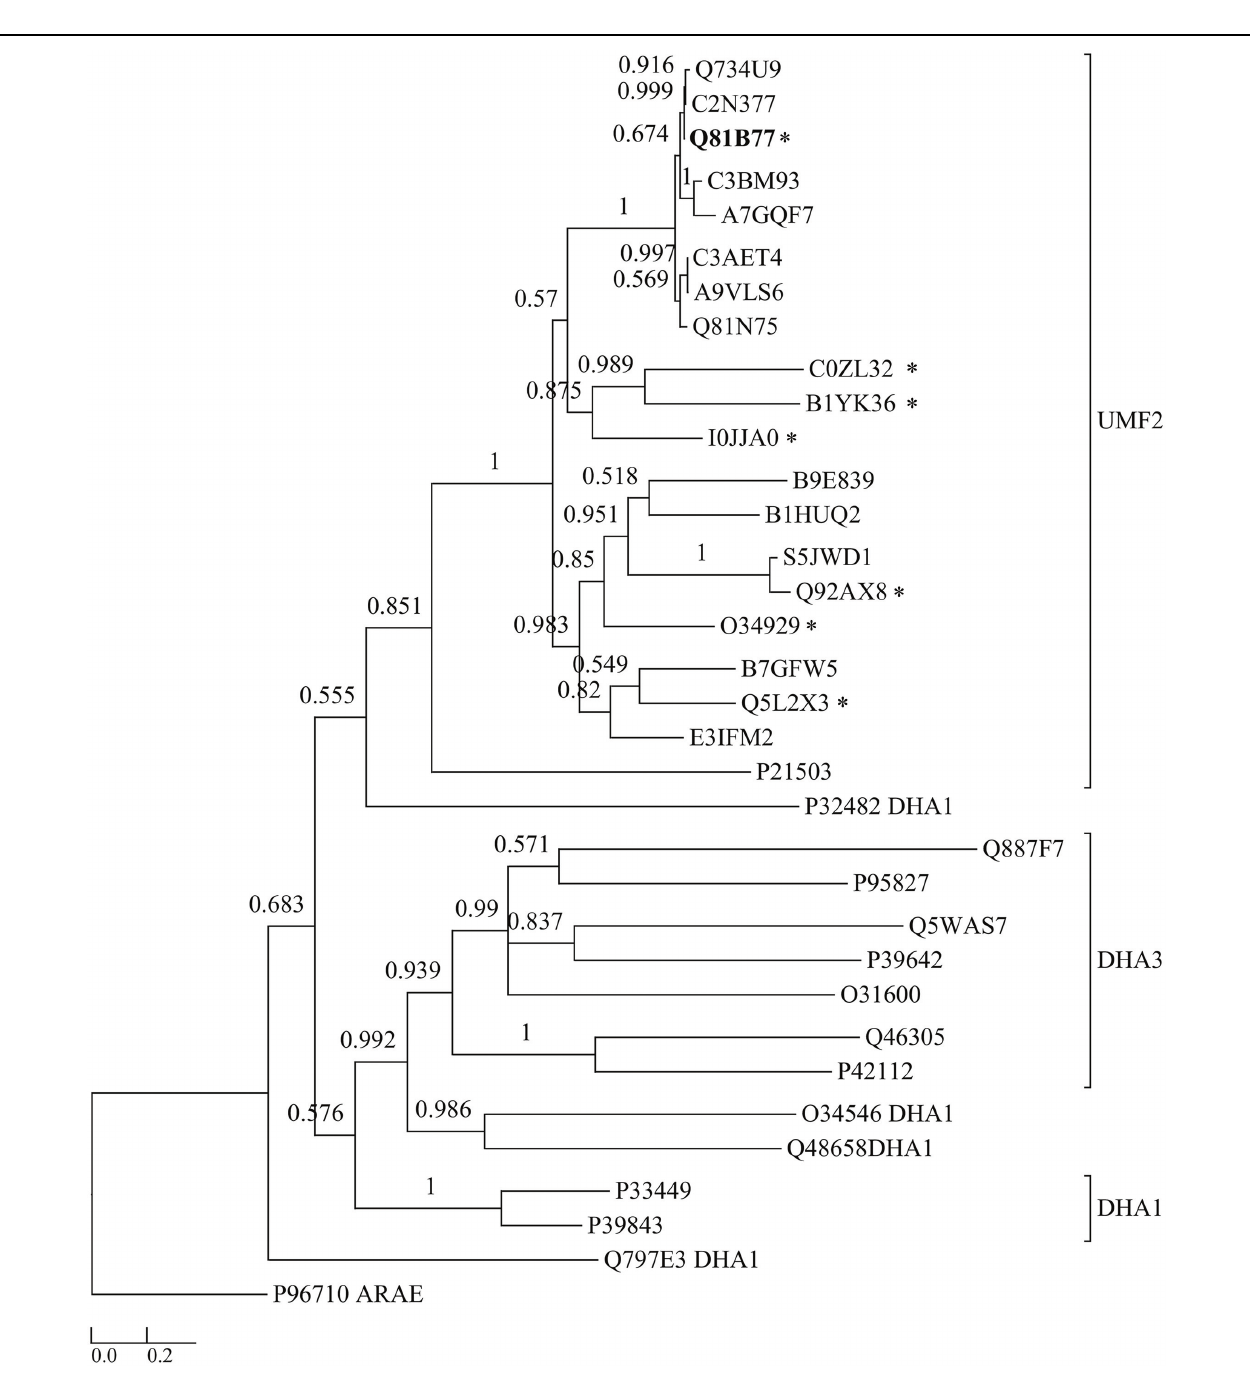
FIGURE 1 | Dendrogram comparing BC3310 from Bacillus cereus ATCC 14579 with orthologous proteins and other multidrug transporters from the DHA1 and DHA3 families. BC3310 from B. cereus ATCC 14579 (UniProt accession number: Q81B77; bold font) and orthologous proteins from B. cereus ATCC 10987 (Q734U9), B. cereus ATCC 10876 (C2N377), B. anthracis str. Ames (Q81N75), B. cereus ssp. cytotoxis (A7GQF7), B. weihenstephanensis (A9VLS6), B. mycoides (C3AET4), B. pseudomycoides (C3BM93), Geobacillus sp. Y4.1MC1 (E3IFM2), Halobacillus halophilus (I0JJA0), B. subtilis (O34929), Listeria innocua (Q92AX8), Listeria monocytogenes (S5JWD1), Geobacillus kaustophilus (Q5L2X3), Lysinibacillus sphaericus (B1HUQ2), Exiguobacterium sibiricum (B1YK36), Anoxybacillus flavithermus (B7GFW5), M. caseolyticus (B9E839), Brevibacillus brevis (C0ZL32), Escherichia coli (P21503), and DHA1 proteins from Lactococcus lactis (Q48658), B. subtilis (Q797E3, O34546, P39843, P33449), Pseudomonas aeruginosa (P32482) and DHA3 proteins from Streptococcus pyrogenes (P95827), B. subtilis (P39642, O31600, P42112), B. clausii (Q5WAS7), Pseudomonas syringae (Q887F7), Clostridium perfringens (Q46305) and the sugar transporter AraE from B. subtilis (P96710) as an outgroup were used to build the tree. Posterior probability values are shown at each node and the bar represents the expected number of amino acid substitutions per site. The seven protein sequences marked with ∗ were aligned in Figure 5 .